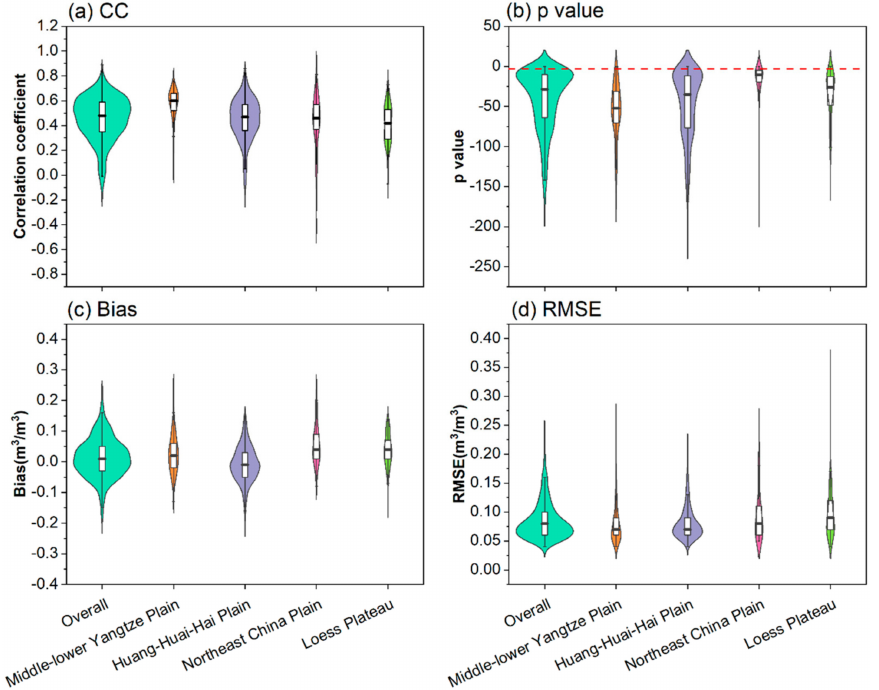
Figure 7. Distribution violin diagrams of CC ( a ), p value ( b ), bias ( c ), and RMSE ( d ) between ERA5- derived RZSM and in situ ground observations. Presented are the median, the 1st quantile Q1 and 3rd quantile Q3 (as indicated by the box), and the Q1 − 1.5(Q3 − Q1) and Q3 + 1.5(Q3 − Q1) values (whiskers). (The red dash line in ( b ) indicates p =